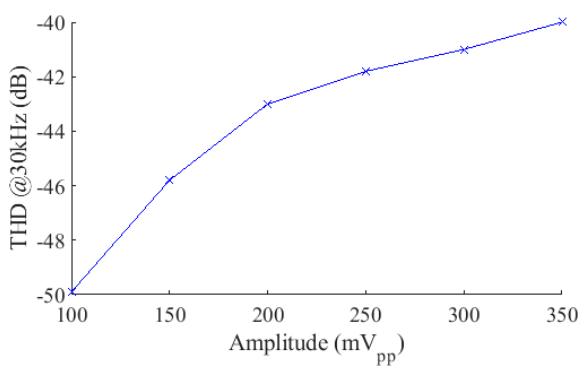
Figure 11. Measured total harmonic distortion (THD) versus input amplitude.